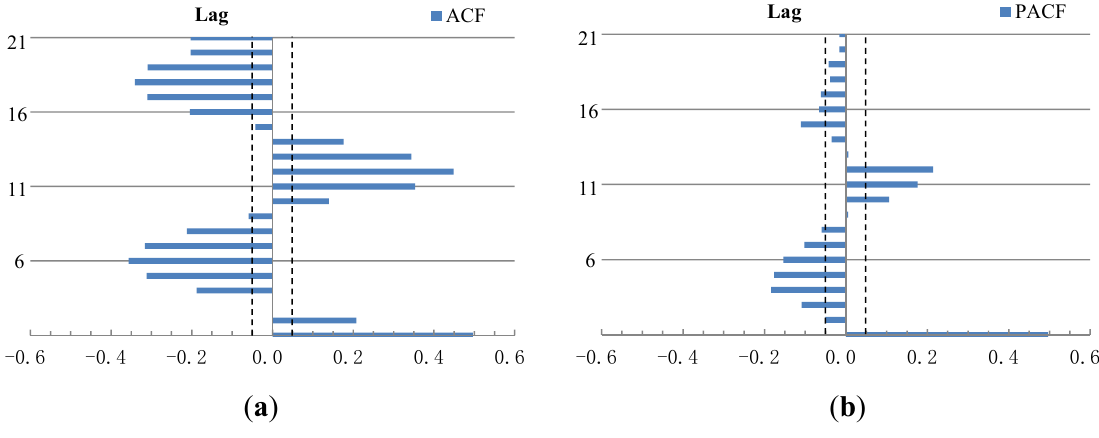
Figure 6. The ( a ) ACF and ( b ) PACF of Xinfengjiang monthly inflow